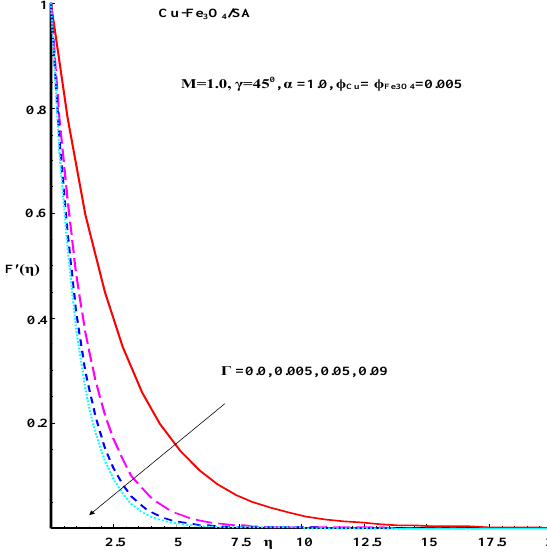
Figure 5. Effect of Casson parameter on velocity